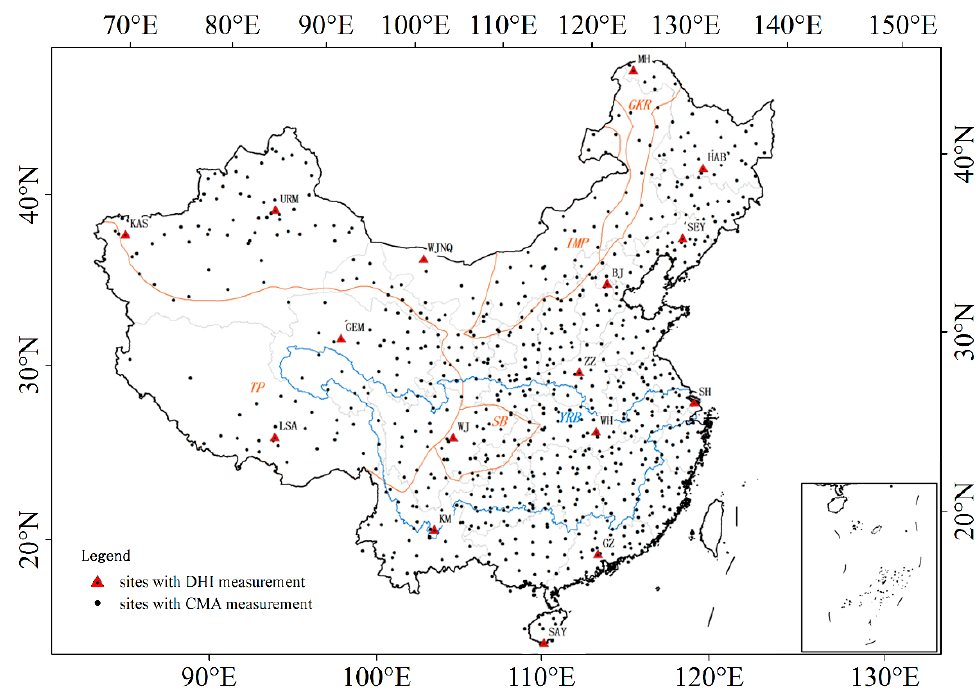
Figure 1. Distribution of the 16 direct horizontal irradiance (DHI) stations and 839 China Meteorological Administration (CMA) stations across China used as data sources (GKR for the Greater Khingan Range; IMP for the Inner Mongolia High Plain; TP for the Tibet Plateau; SB for the Sichuan Basin; YRB for the Yangtze River Basin).